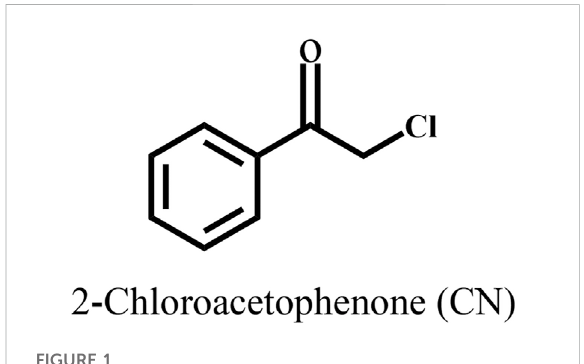
Chemical formula of 2-chloroacetophenone